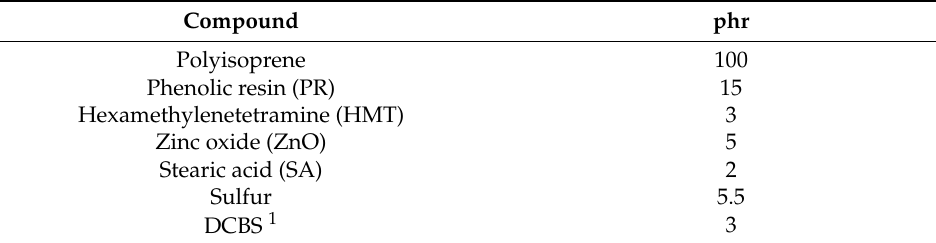
taining polyisoprene as shown in Table A3. All the values are indicated in phr (parts per hundred rubber). Additionally, the mixing procedure is detailed above (Table A1). Table A3. Formulation containing polyisoprene and phenolic system.